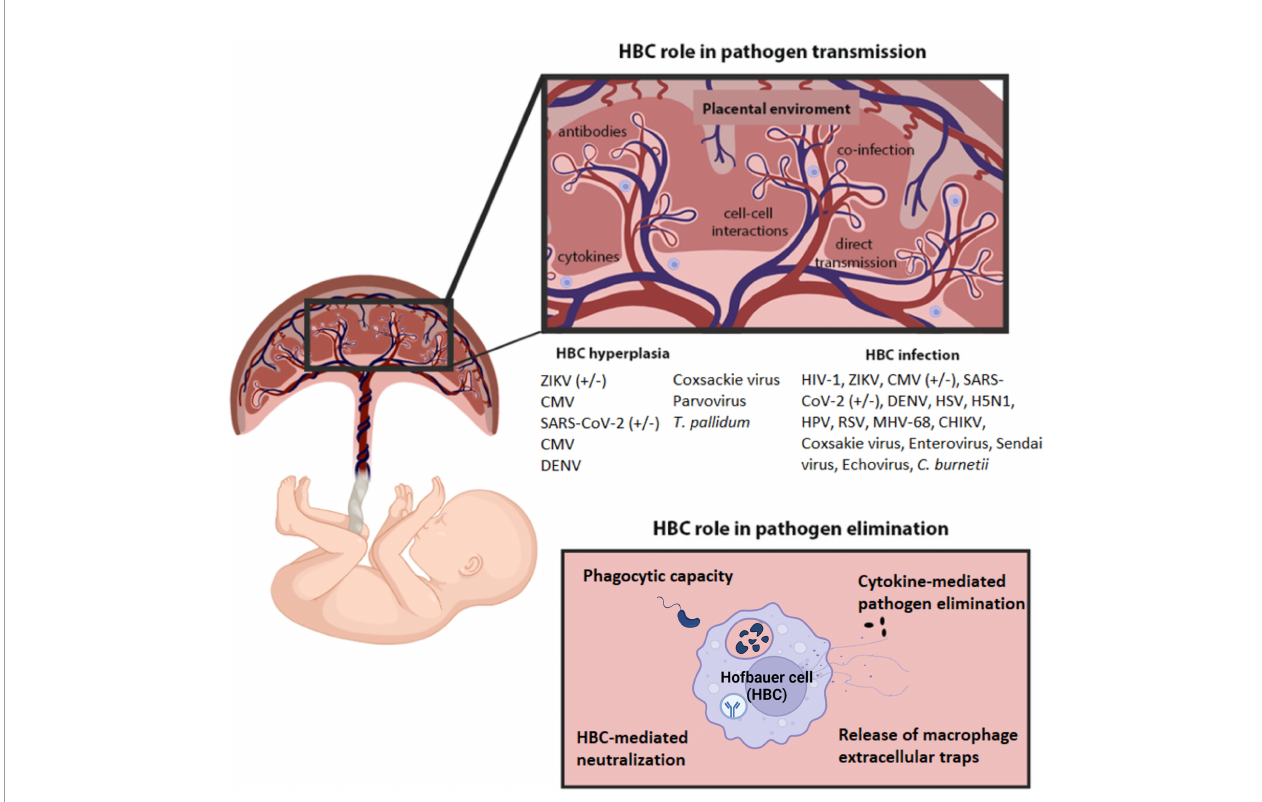
FIGURE 3 | Overview of the role of HBCs in pathogen infection and pathogen elimination. HBCs can be infected by a range of pathogens, which in some cases can replicate and transmit to other cells. Some pathogens induce HBC hyperplasia which may contribute to pathogen spread by increasing pathogen reservoirs. Release of cytokines during infection may contribute to pathogen elimination or enhance pathogen replication in HBCs. Other factors, such as antibodies and cytokines also in fl uence HBC susceptibility to infection. However, HBCs also have the capacity to eliminate pathogen invasion by phagocytosis or the release of METs and pathogen neutralization. Created with